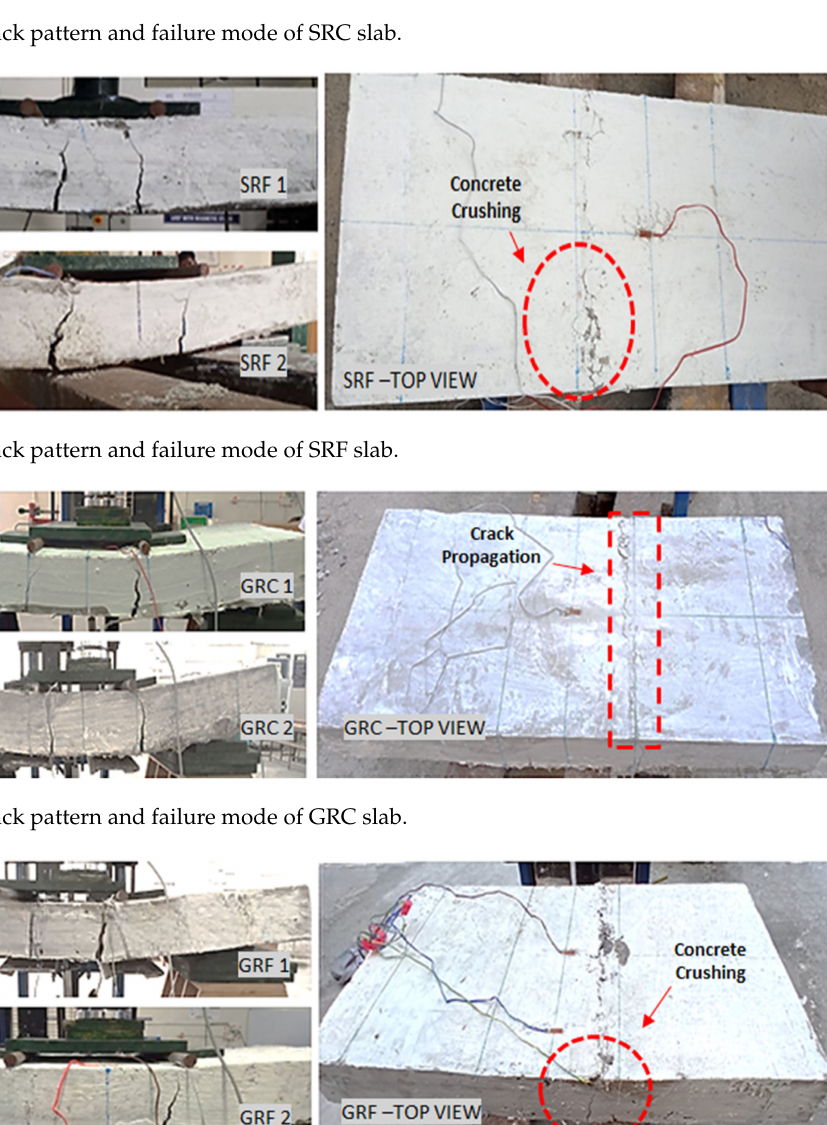
Figure 6. Crack pattern and failure mode of GRF